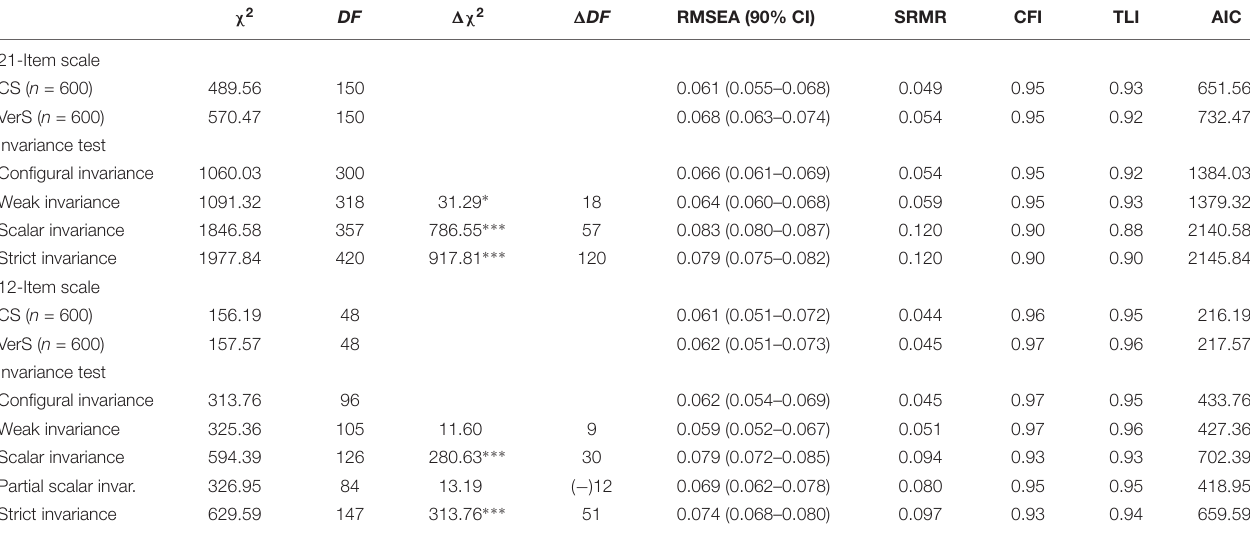
TABLE 4 | Test of measurement invariance of Basic Psychological Needs at Work Scale with 21 and 12 items in two random samples. χ 2 DF (cid:49) χ 2